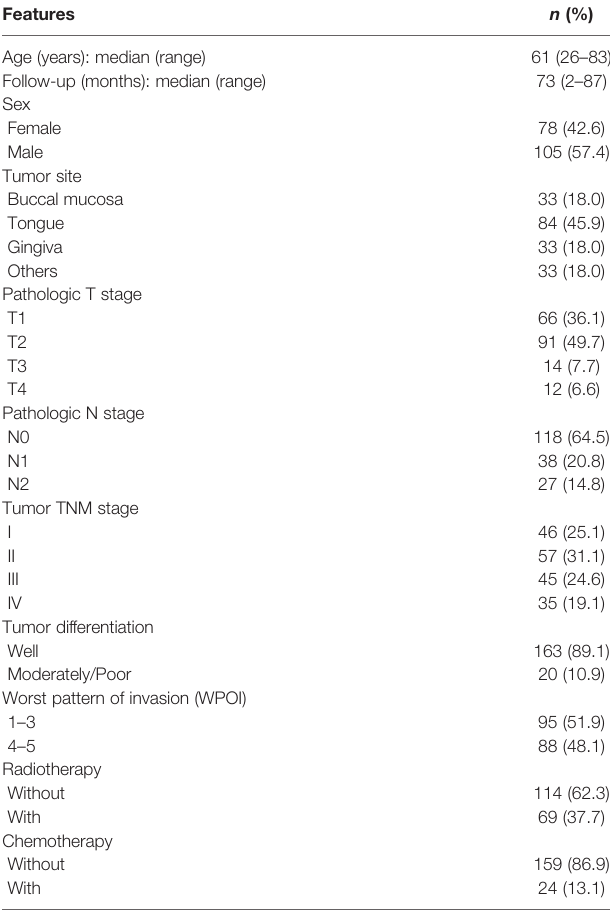
TABLE 1 | Clinicopathological features of 183 OSCC patients in this